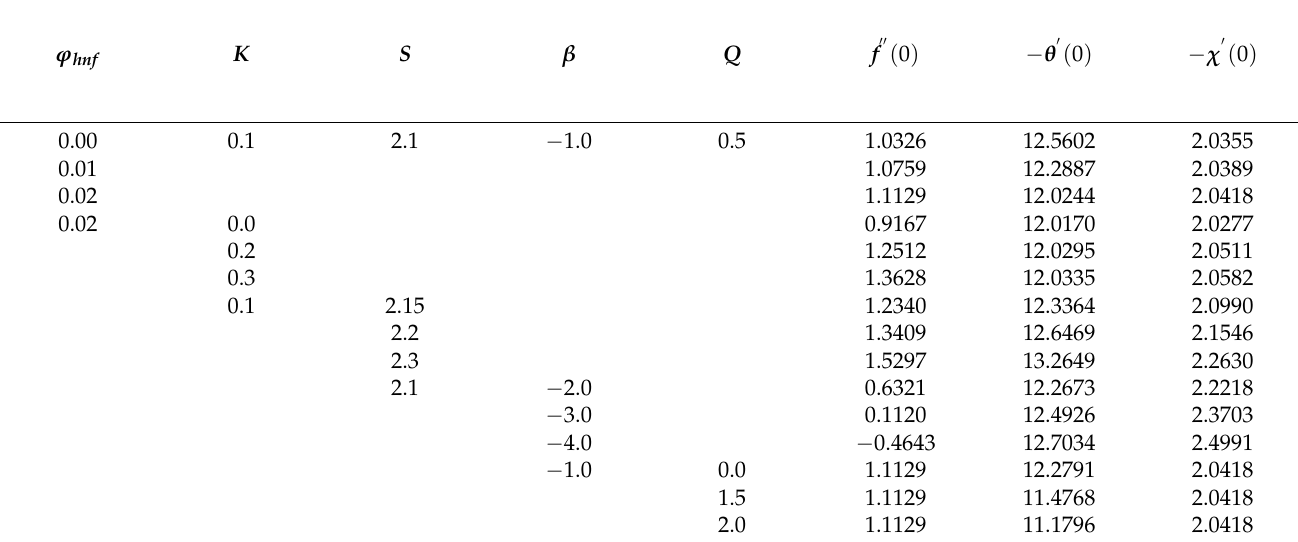
Table 3. Values of the physical quantities for several choices of constraints when λ = − 1 (shrinking sheet), Pr = 6.2, and Sc =